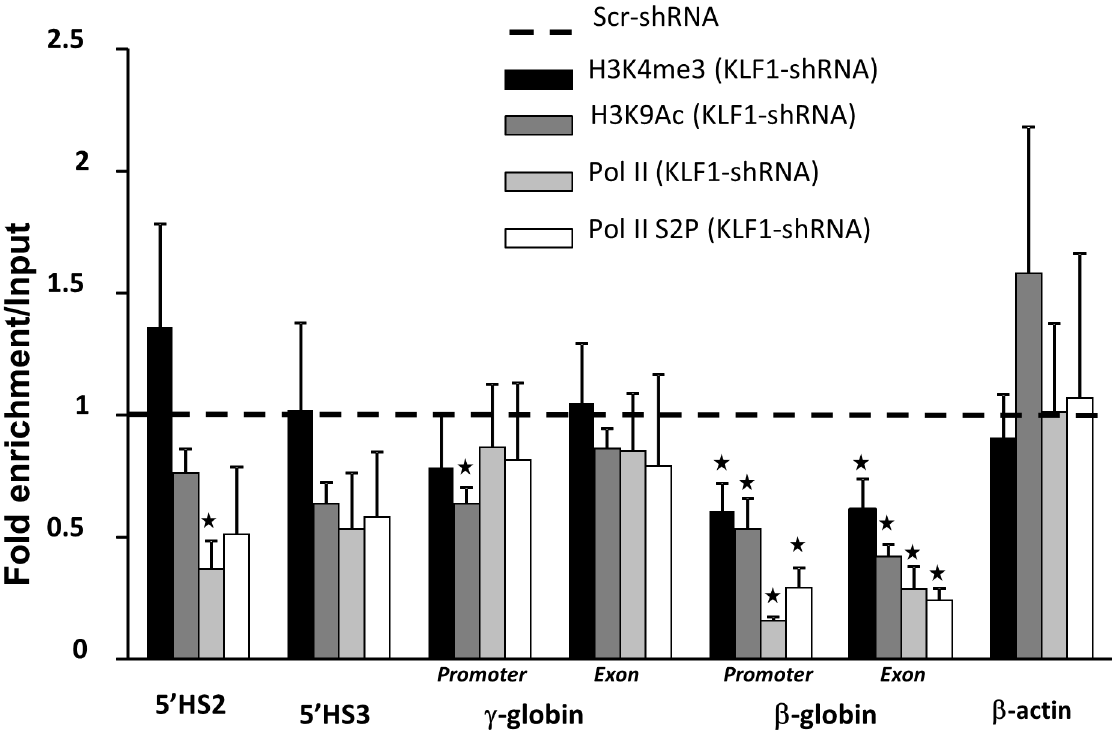
Fig 3. KLF1 knockdown reduces H3K4me3 and RNA polymerase II recruitment at the β - but not γ -globin gene. ChIP assays were performed using anti-H3K9Ac, anti-H3K4me3, anti-RNA Pol II or anti-RNA Pol II S2P antibodies on Scr and KLF1 shRNA-treated UCB erythroblasts. H3K9 acetylation generally indicates open chromatin configuration and H3K4 trimethylation marks regions of active transcription. qPCR was used to quantify enrichment at 5 ’ HS3, 5 ’ HS2 and at sites within the promoter and exon 2 of the γ - and β -globin genes. The primers for the γ -globin promoter and exon collectively measure the A γ - and G γ -globin genes. Non-specific antibodies (IgG) were used as a control for antibody specificity. β -actin was used as a control gene not regulated by KLF1. All regions of the globin locus that were tested show significant enrichment for H3K9Ac, H3K4me3, RNA Pol II and RNA Pol II-S2P compared to IgG in normal (Scr-shRNA treated) cells (data not shown). Enrichment in Scr shRNA-treated cells was set to 1 and relative enrichment in KLF1 shRNA-treated cells is shown for each genomic region tested. N = 4, error bars = standard error, * = p-value < 0.05 compared to Scr shRNA. Residual KLF1 mRNA = 11 – 31% in KLF1 shRNA-treated